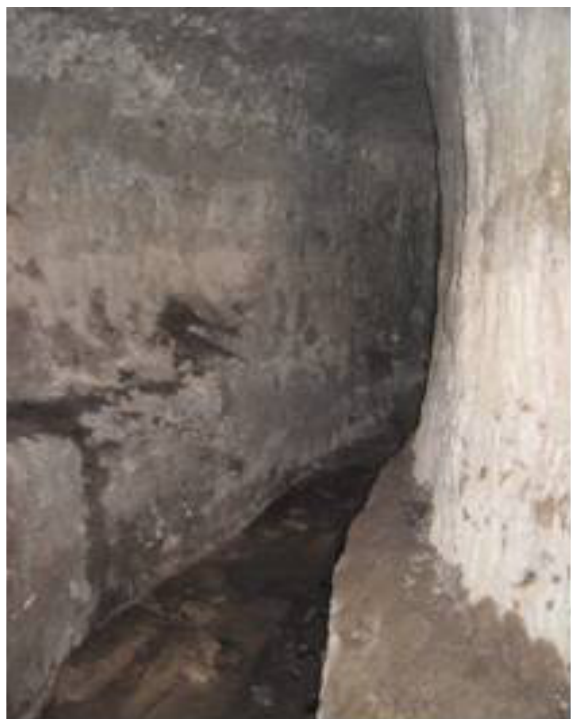
Figure 8. Part of the tunnel of aqueduct 1